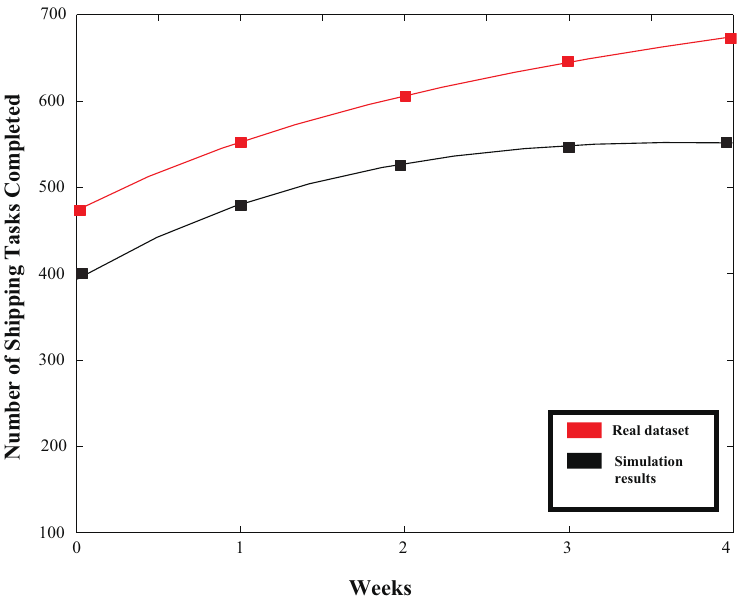
Figure 13. Comparing the actual and simulated average shipment completion